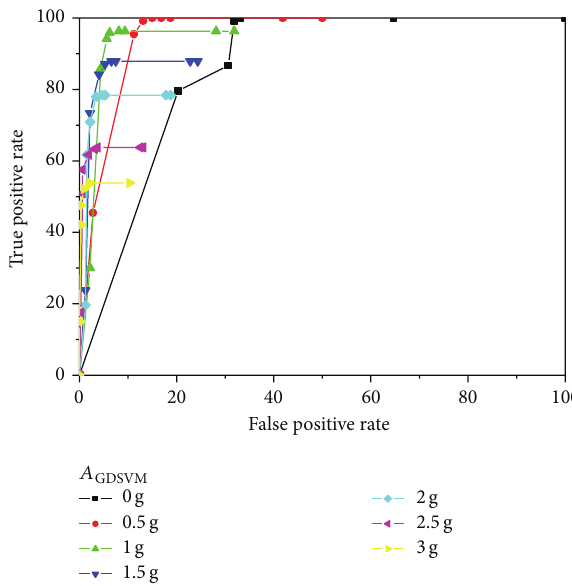
Figure 6: ROC curve of fall detection obtained from the simple Figure 8: ROC curve of fall detection obtained from the simple and 𝜃 . threshold using the double fall-feature parameters of 𝐴 DSVM and threshold using the double fall-feature parameters of 𝐴 GDSVM The best fall detection is of sensitivity 98.33%, specificity 90.94%, 𝜃 . The best fall detection is of sensitivity 95.83%, specificity 93.75%, = 1g and 𝜃 = 65 ∘ . and accuracy 95.16% when 𝐴 DSVM = 1g and 𝜃 = 60 ∘ . and accuracy 94.94% when 𝐴 GDSVM Table 2: Best fall and ADL detection results evaluated by applying the parameter 𝜃 of the observation samples determined with fall events shown in Table 1 to the HMM algorithm shown in Algorithm 2 (sensitivity = 99.17% and specificity = 99.69% and accuracy = 95.89%).